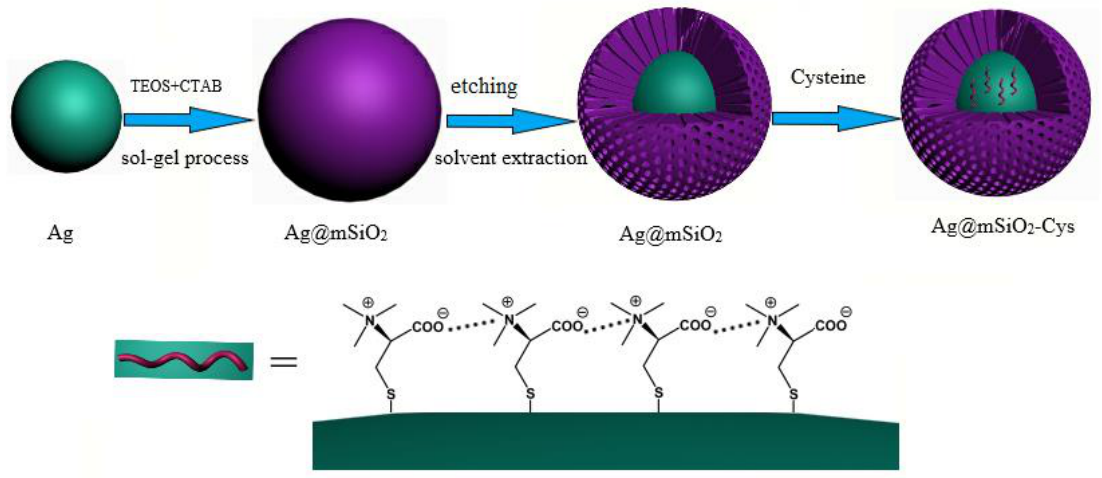
Scheme 1. Illustration of the synthesis process for Ag@mSiO 2 and application for cysteine detection.